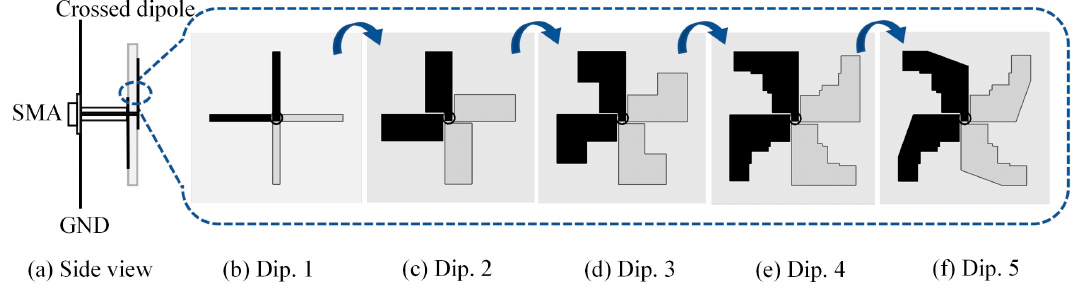
Figure 2. Configuration evolution of the dipole and the side view of each antenna.